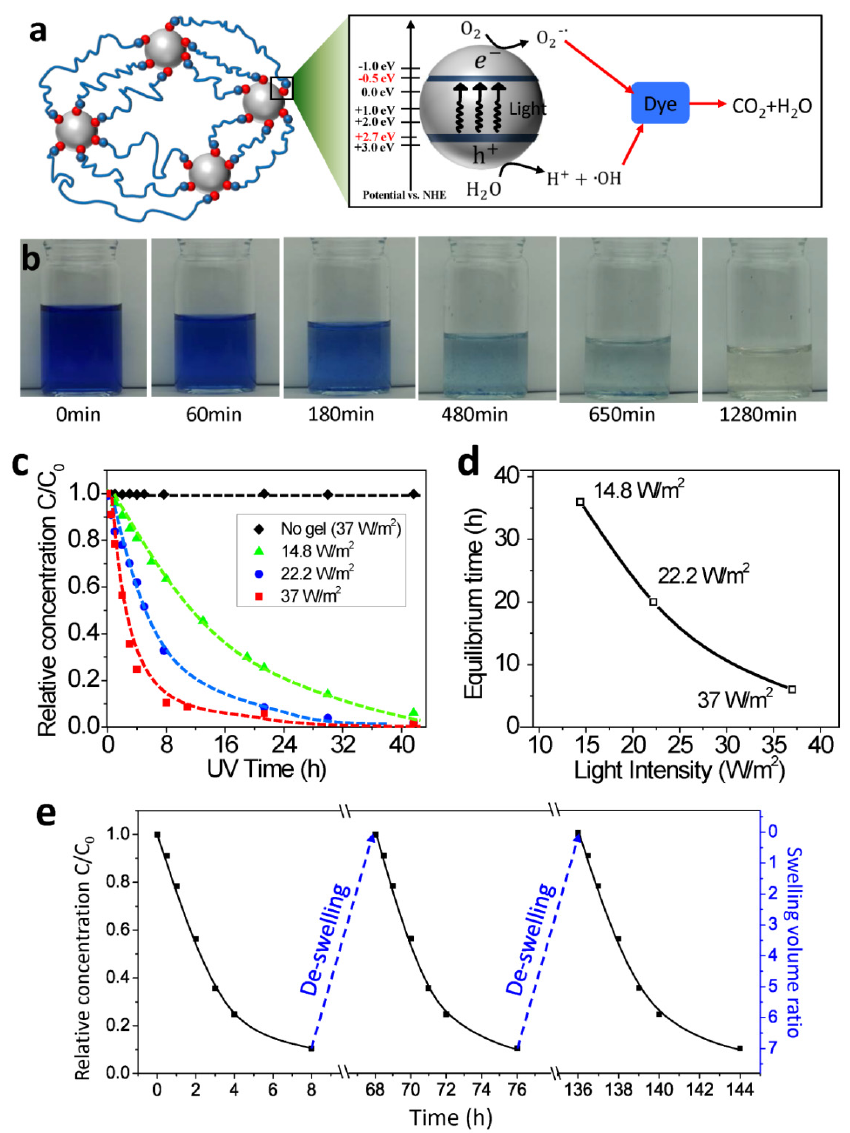
Figure 4. ( a ) Schematics to show the mechanism of light ‐ assisted dye degradation. ( b ) Image